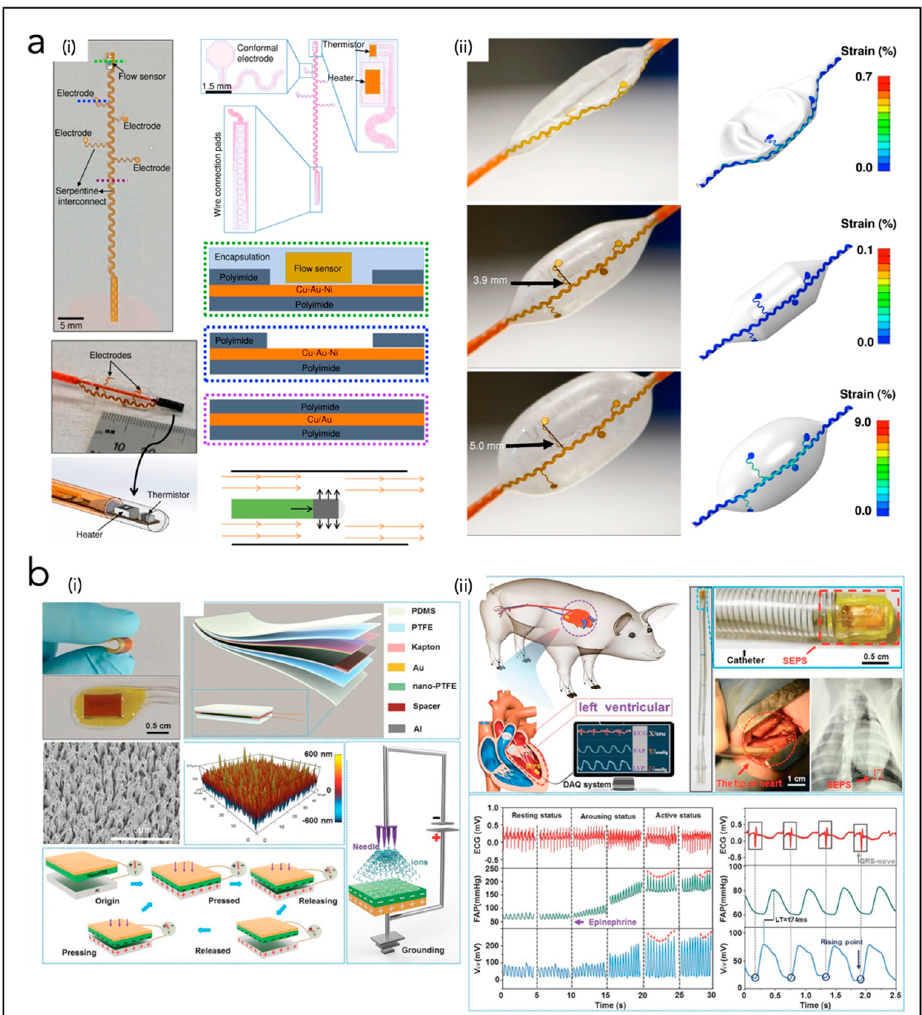
Figure 8. Endocardial cardiac bioelectronic systems. ( a ) Balloon catheter integrated electronics with a stretchable interconnected array of electrodes and flow sensors (i), exhibiting high deformability during deflation-inflation cycles (ii). Adapted with permission from reference [215], 2015 Copyright Elsevier. ( b ) Self-powered ultrasensitive endocardial pressure sensor (i), and in vivo testing in an adult Yorkshire swine’s heart (ii). Adapted with permission from reference [218], 2018 Copyright, Wiley.